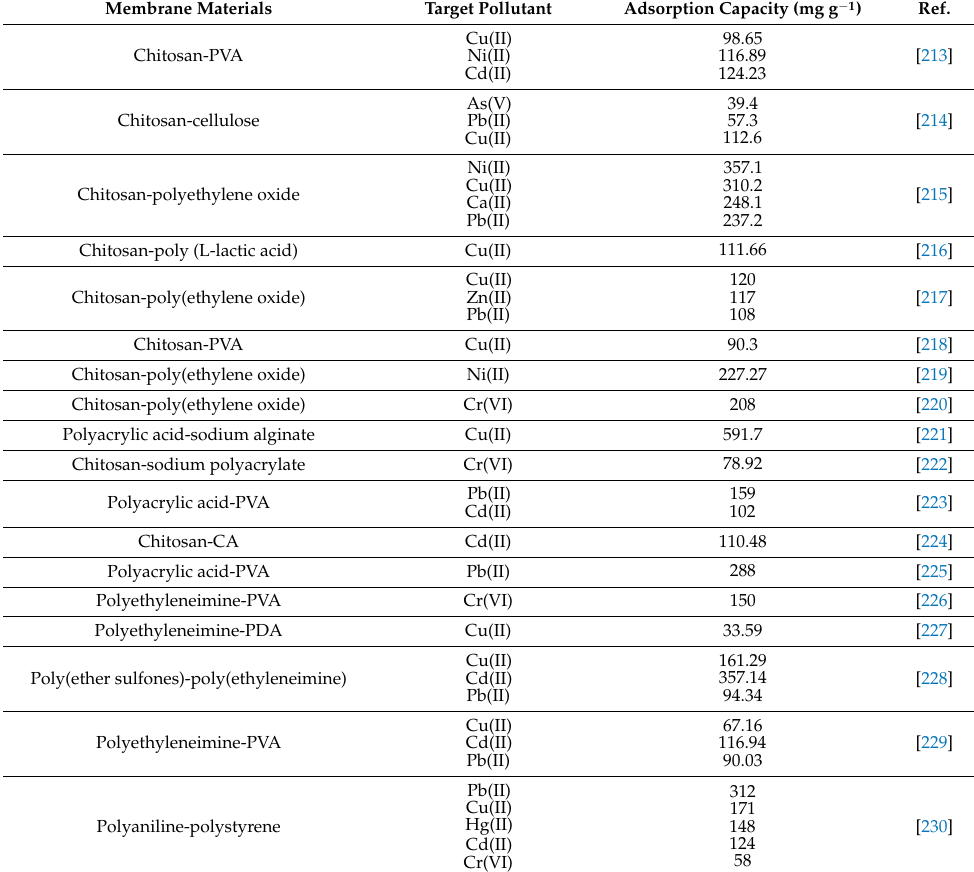
Table 7. A view of recently developed membranes and their adsorption